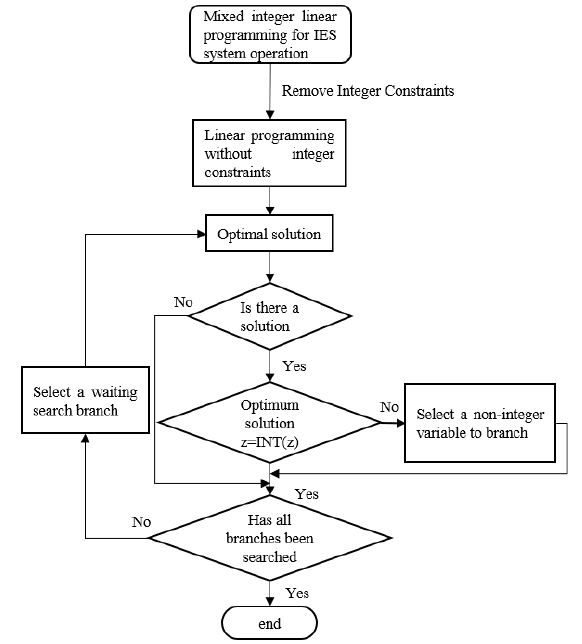
Figure 5. Branch and bound algorithm flow